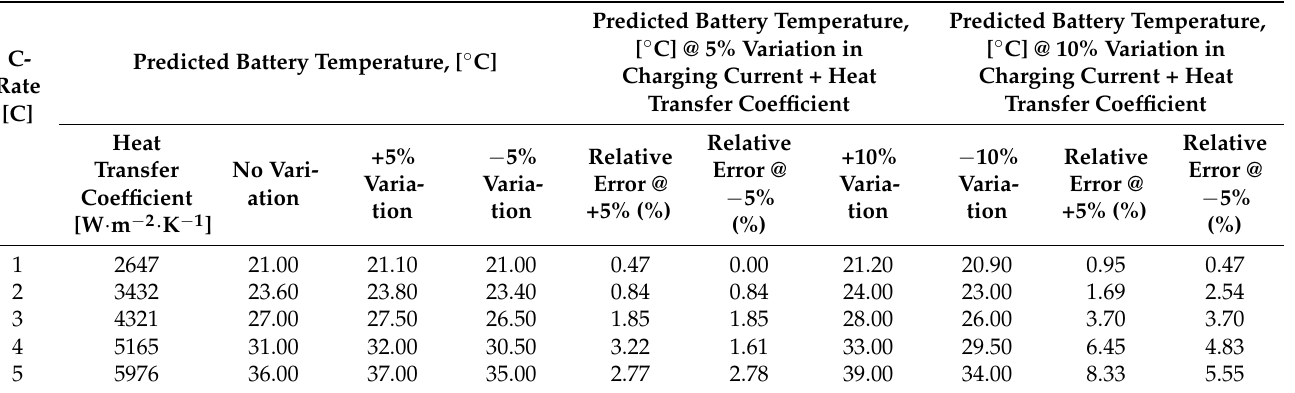
Table 7. Errors in predicted battery temperature with various charging rates and heat